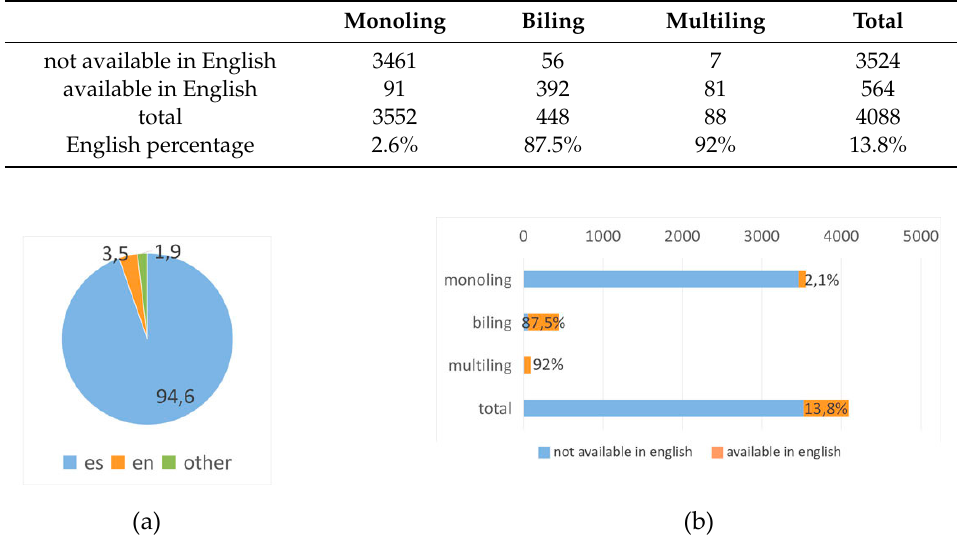
Figure A26. Visualization of the results for domain es. ( a ) Primary languages pie chart and ( b ) English language availability bar chart.